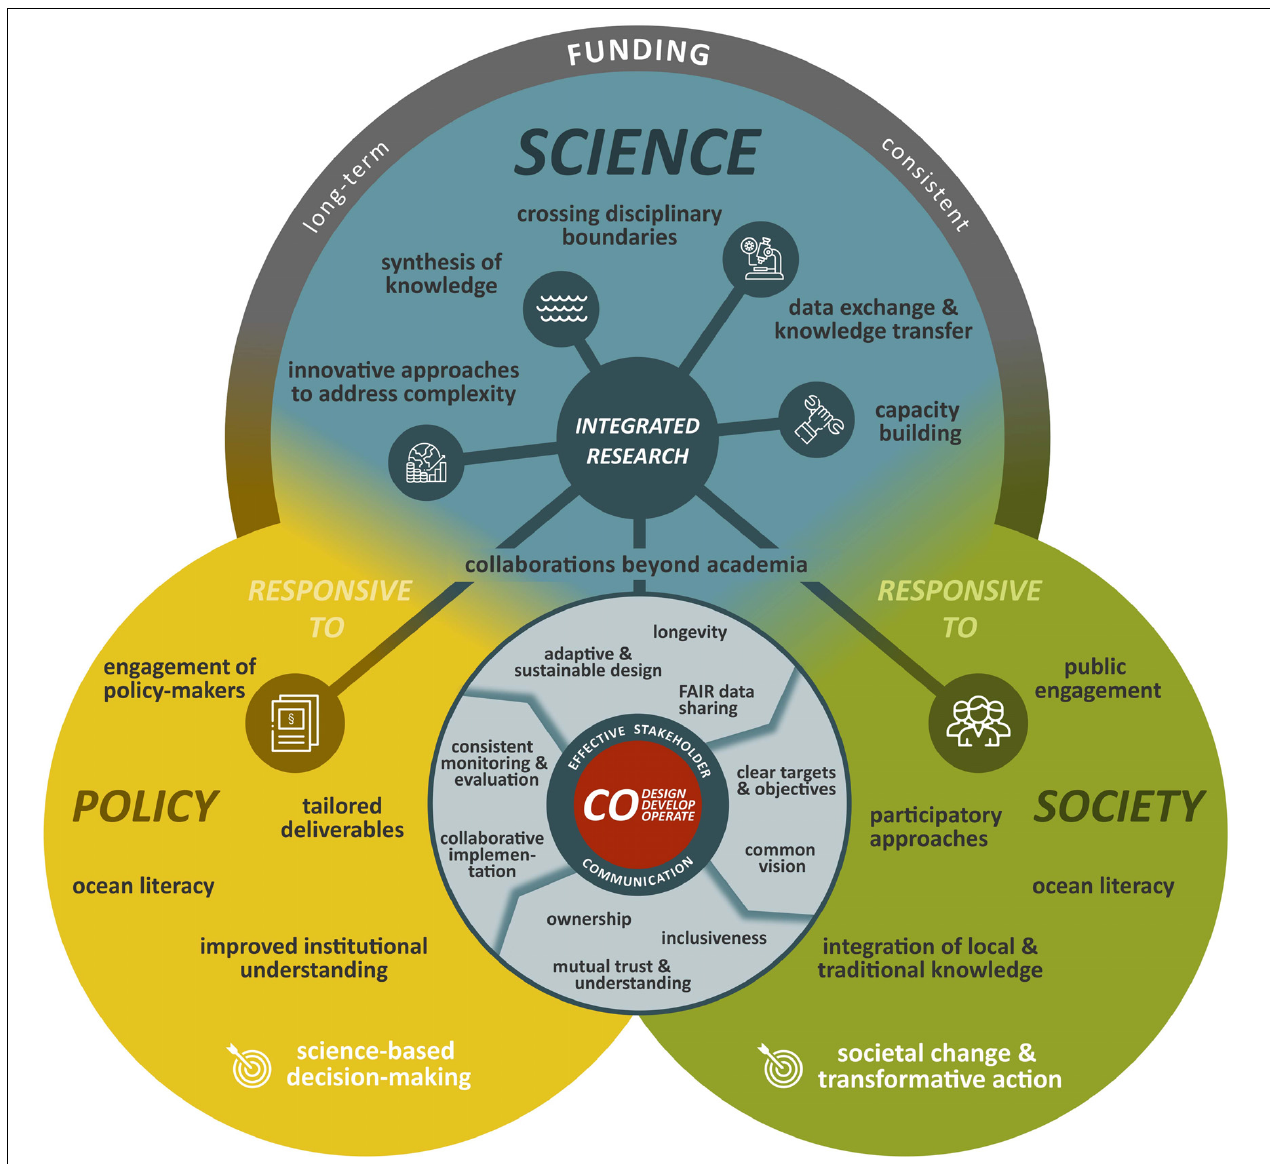
FIGURE 3 | Schematic overview of key considerations for an integrated research design, based on a co-developed approach with policy and society to effectively bridge the research-implementation